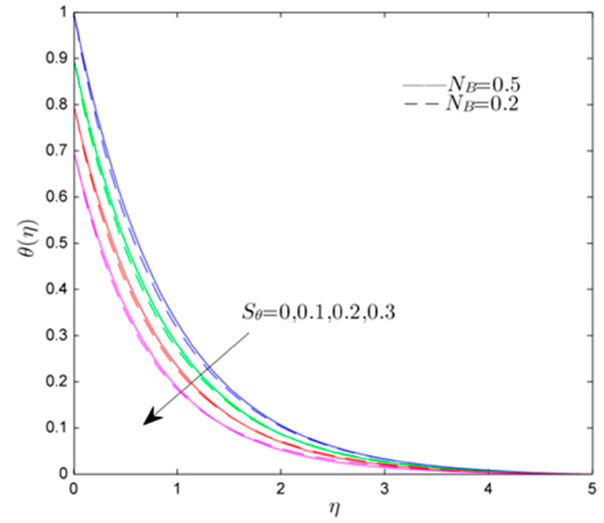
Figure 12. Effect of thermal stratification parameter ( S θ ) on θ ( η ) .